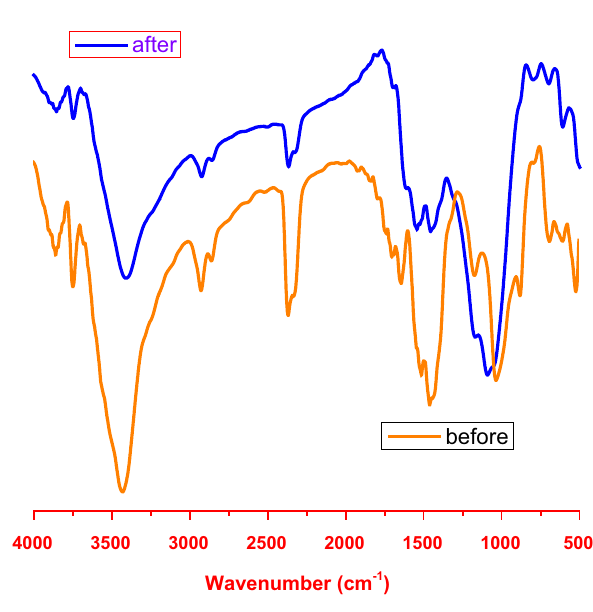
Fig. 6 FTIR spectra of PACW before and after adsorption of